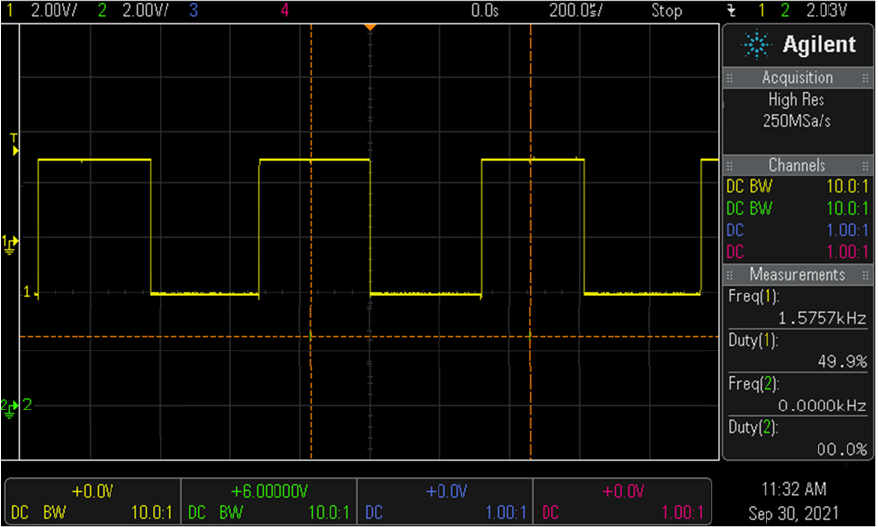
Sensors 2022 , 22 , x FOR PEER REVIEW Figure 9. Result of simulating the pulse signal of the Colpitts oscillator. Figure 9. Result of simulating the pulse signal of the Colpitts oscillator.